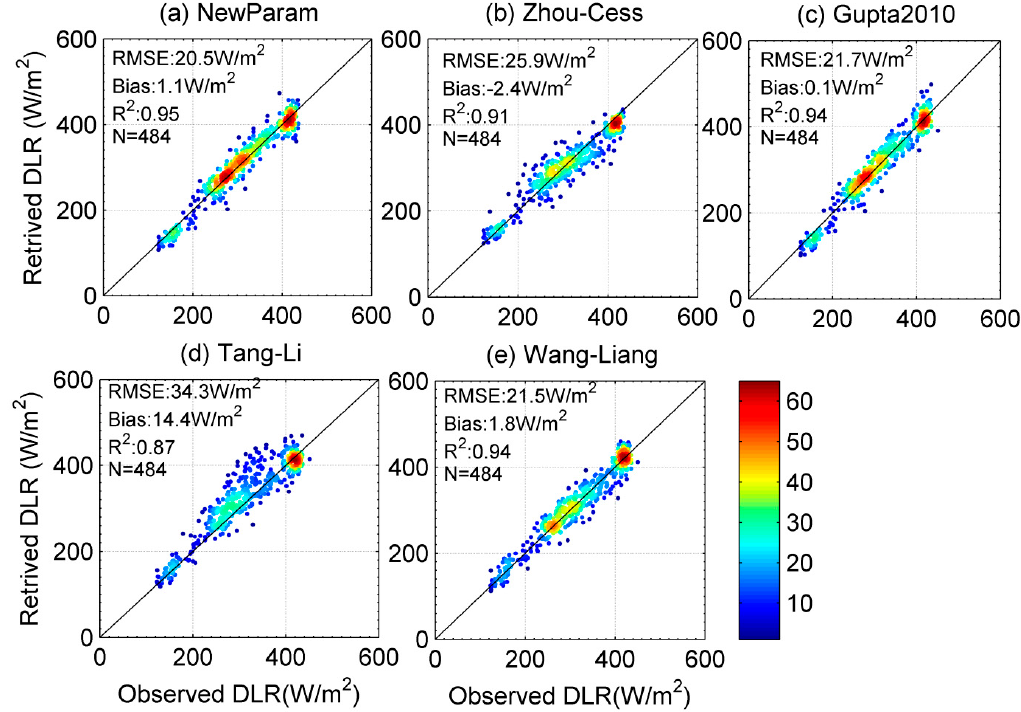
Figure 9. Comparison between MODIS-estimated DLRs and in-situ measurements at the sites in ordinary regions. Figures ( a ) to ( e ) represent the results from the new parameterization (NewParam), Tang-Li, Wang-Liang, Zhou-Cess, and Gupta2010 algorithms. The color bar represents data density that ranges from 0 to 100 percent of the data.